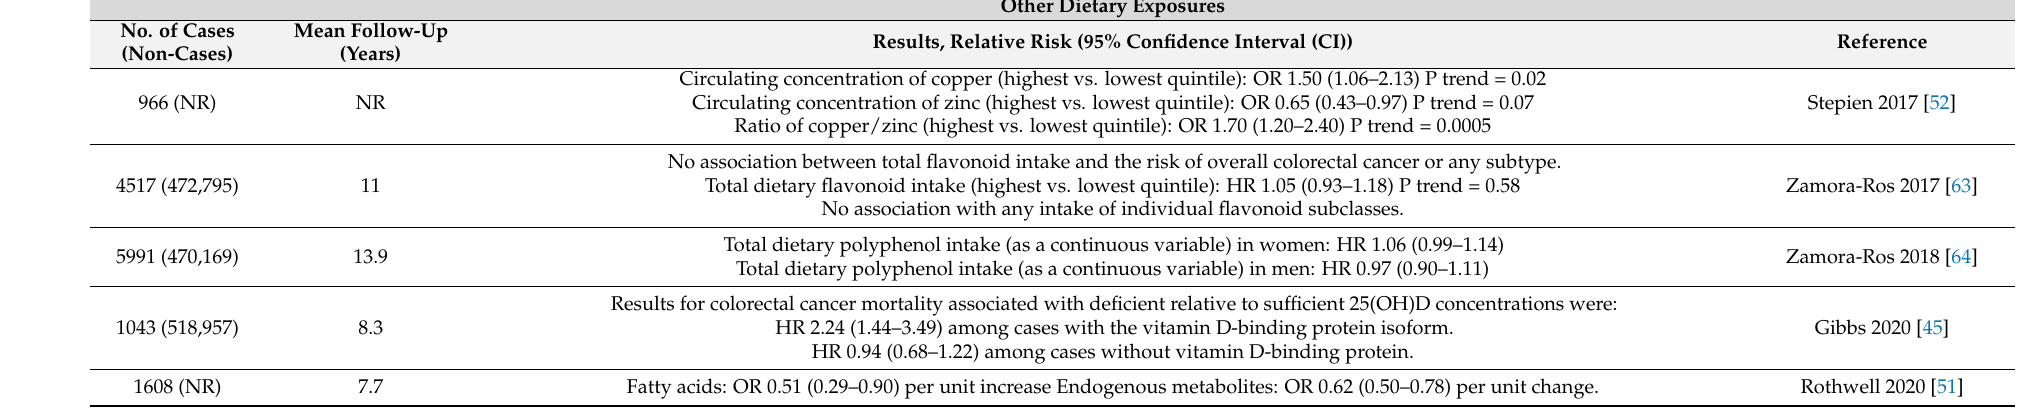
Table 1. Cont. Other Dietary Exposures